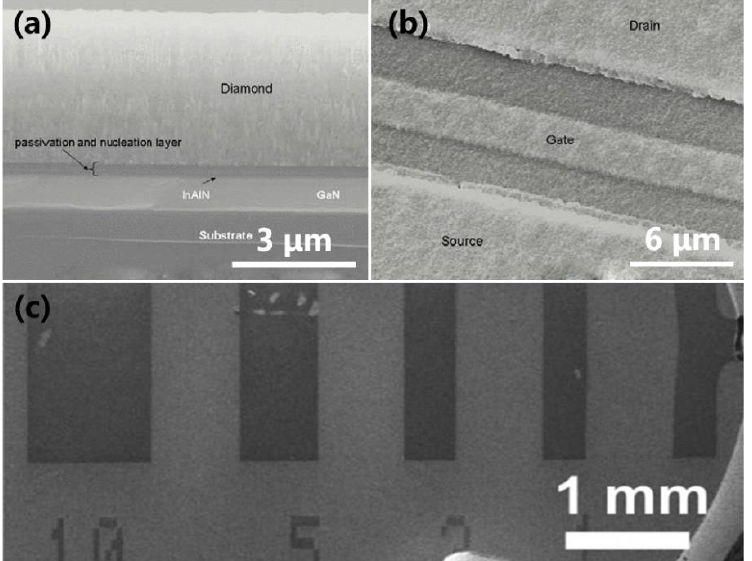
Figure 7. Cross-section ( a ) and surface ( b ) morphology of GaN HEMT coated with a 4.5 μm -thick diamond layer [95]. Surface ( c ) morphology of NCD grown on a GaN substrate via selective area deposition [80].